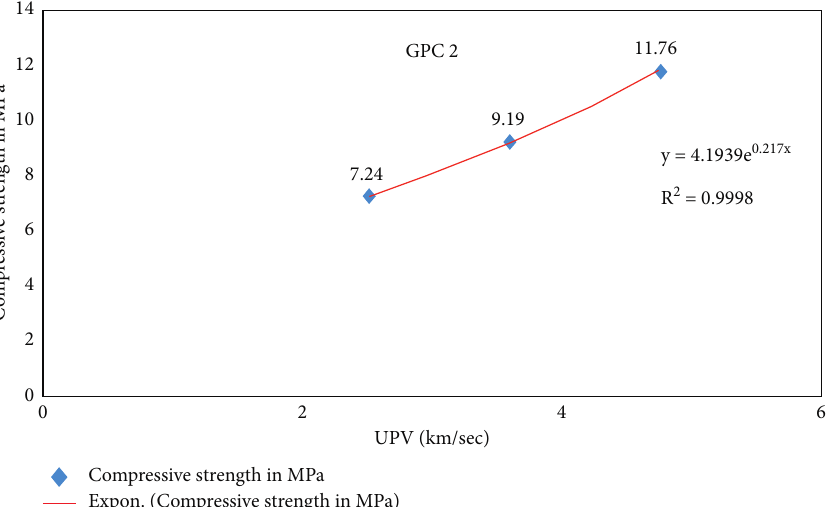
Figure 9: Relation between compressive strength and UPV for GPC